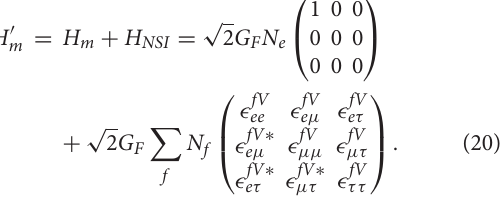
c 23 ν µ s 23 ν τ is the combination that ν ≡ −